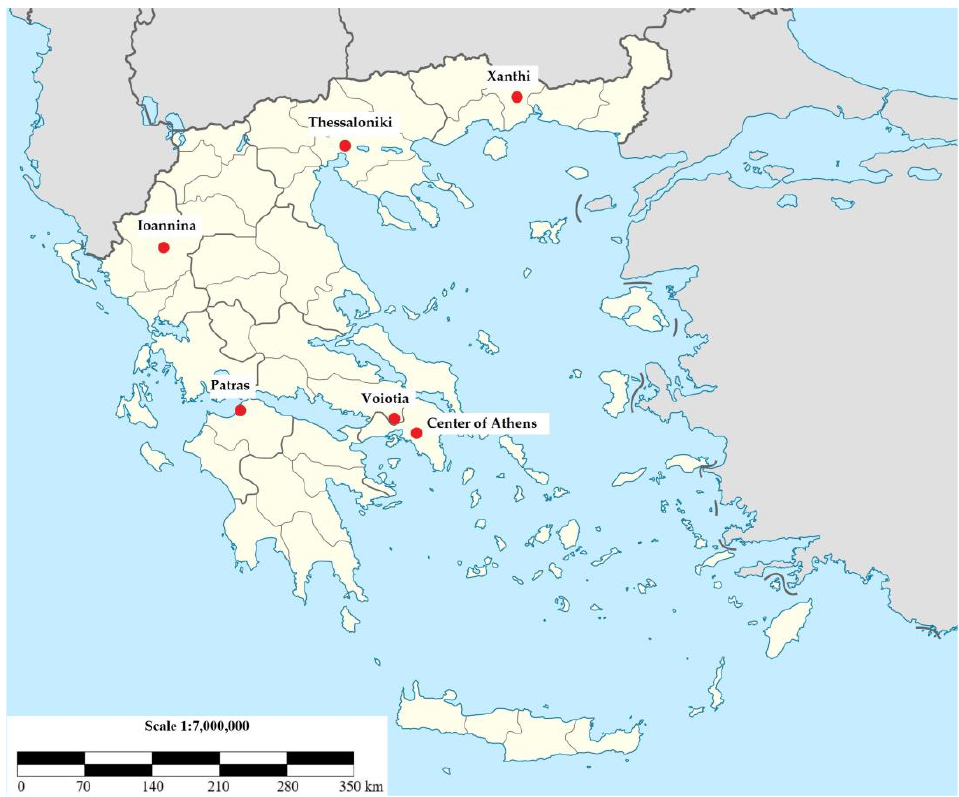
Figure 1. Selected areas for exposure.